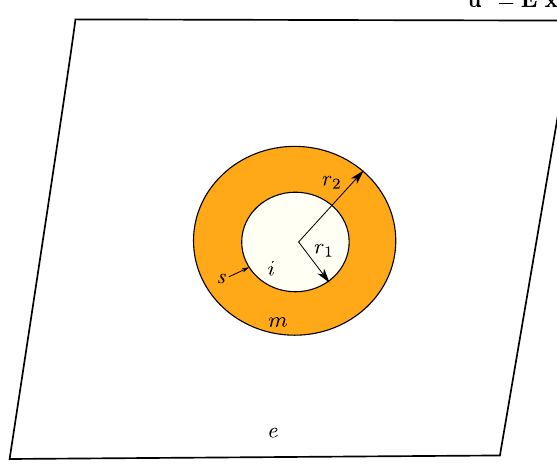
Figure 4. Generalized self-consistent micromechanical